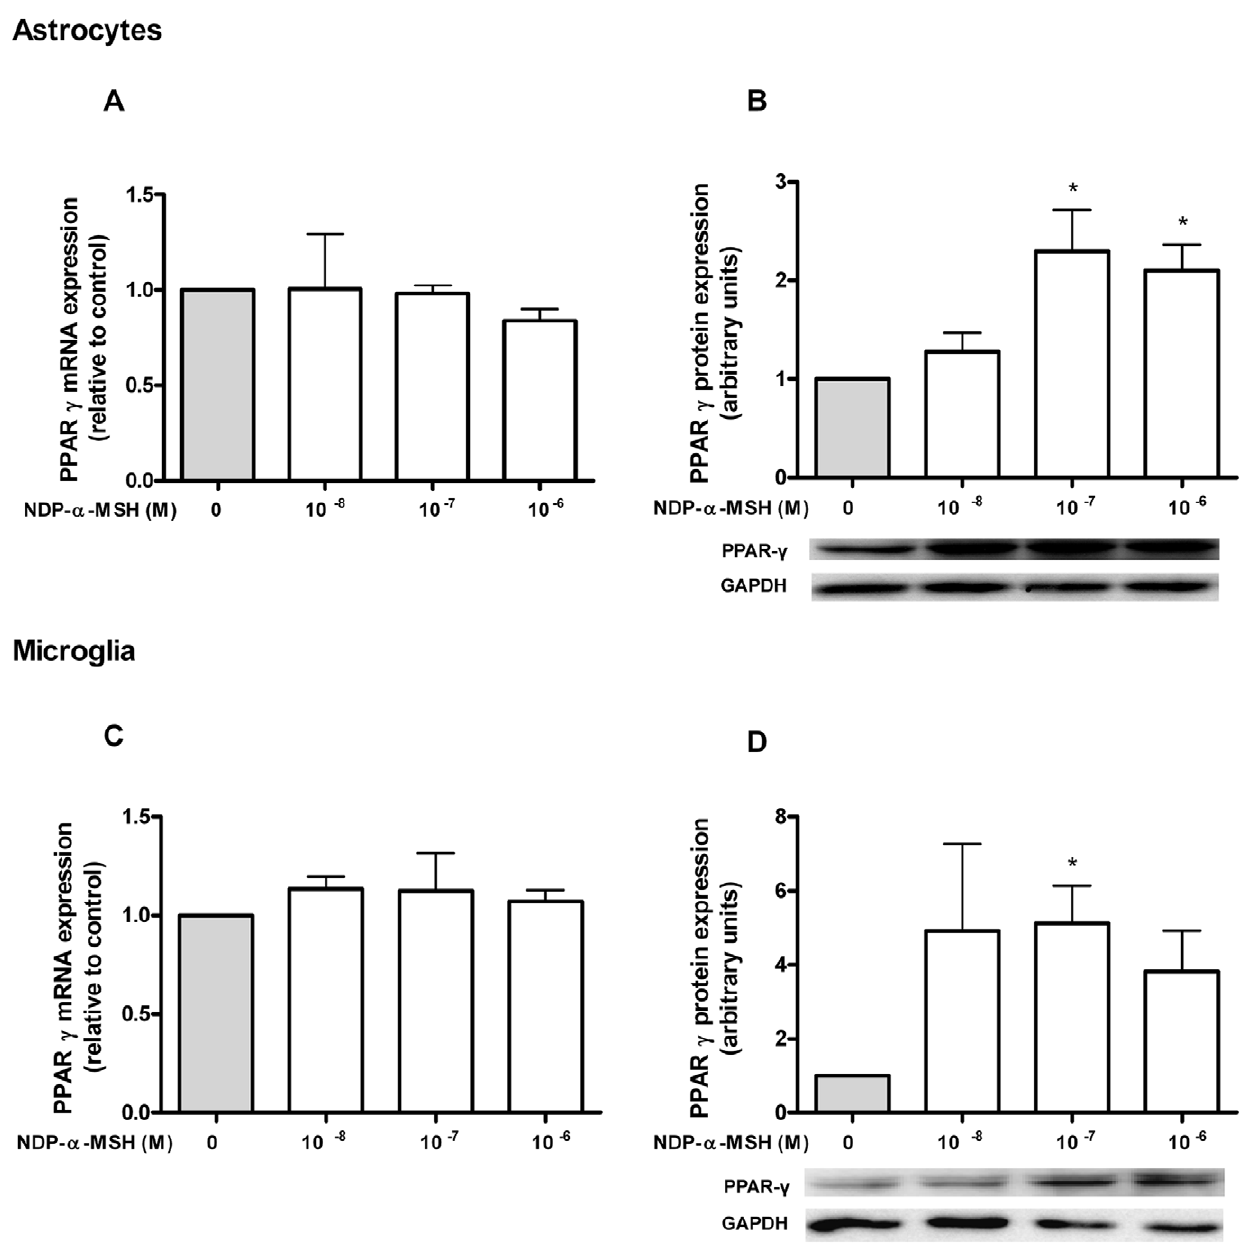
Figure 2. PPAR- c expression in rat astrocytes and microglia. (A and C) Gene expression was studied by RT-qPCR as described in Materials and Methods. No significant change in PPAR- c mRNA levels was observed after 24 h of incubation with NDP- a -MSH in both cell types. (B and D) Protein expression of PPAR- c was assessed by western blot after 24 h of treatment. NDP- a -MSH induced the expression of PPAR- c protein in both cell types. Data were analyzed by one sample t Test and are expressed as mean 6 SEM. * p , 0.05 vs. control